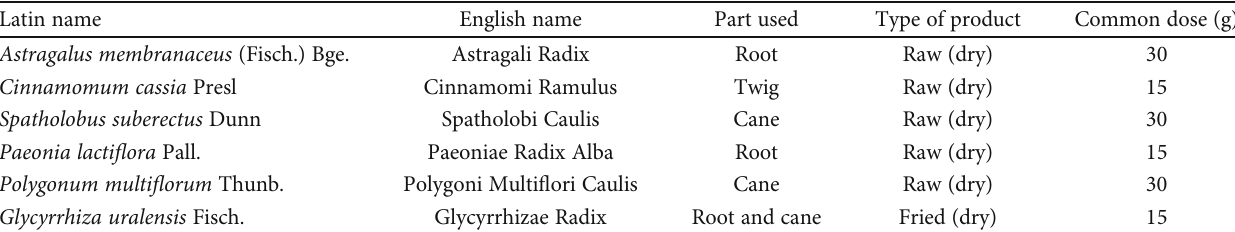
Table 1: Composition of modi fi ed